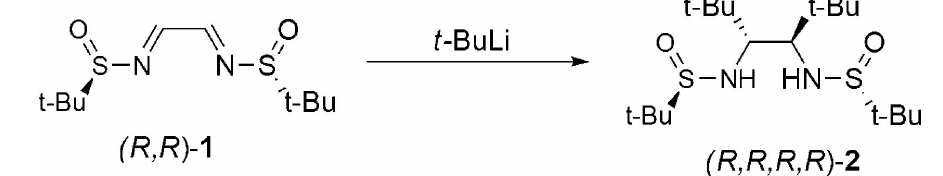
Figure 3 The formation of the title